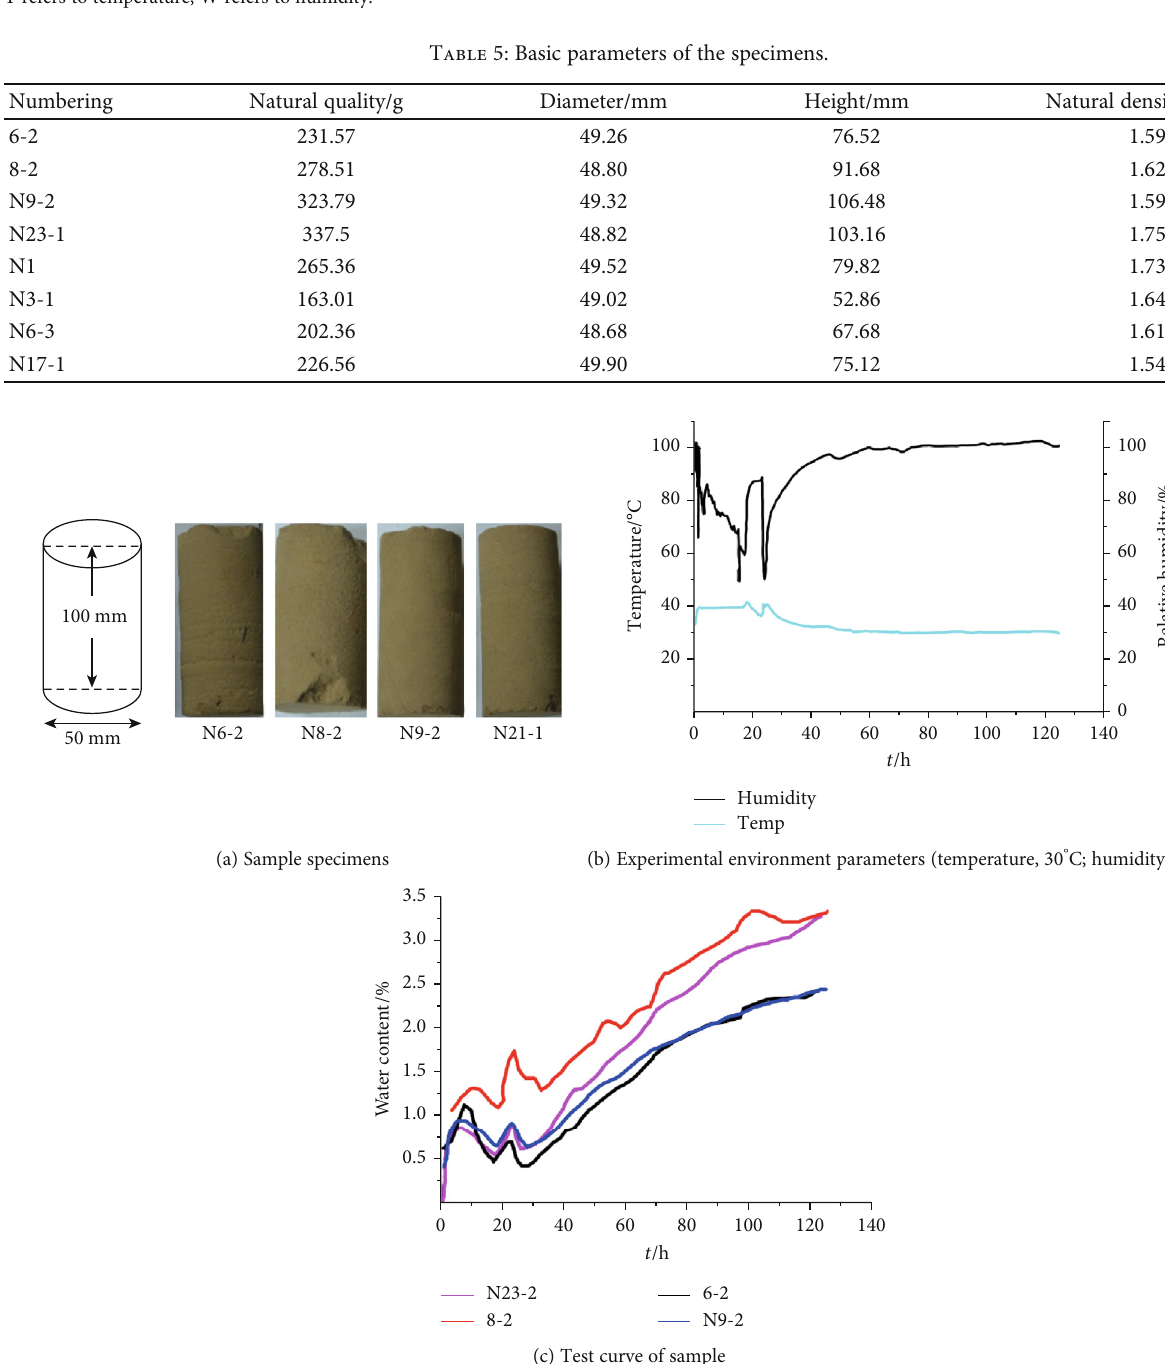
Figure 27: Gaseous water adsorption experiment of mudstone in Mogao Grottoes in the summer in Group